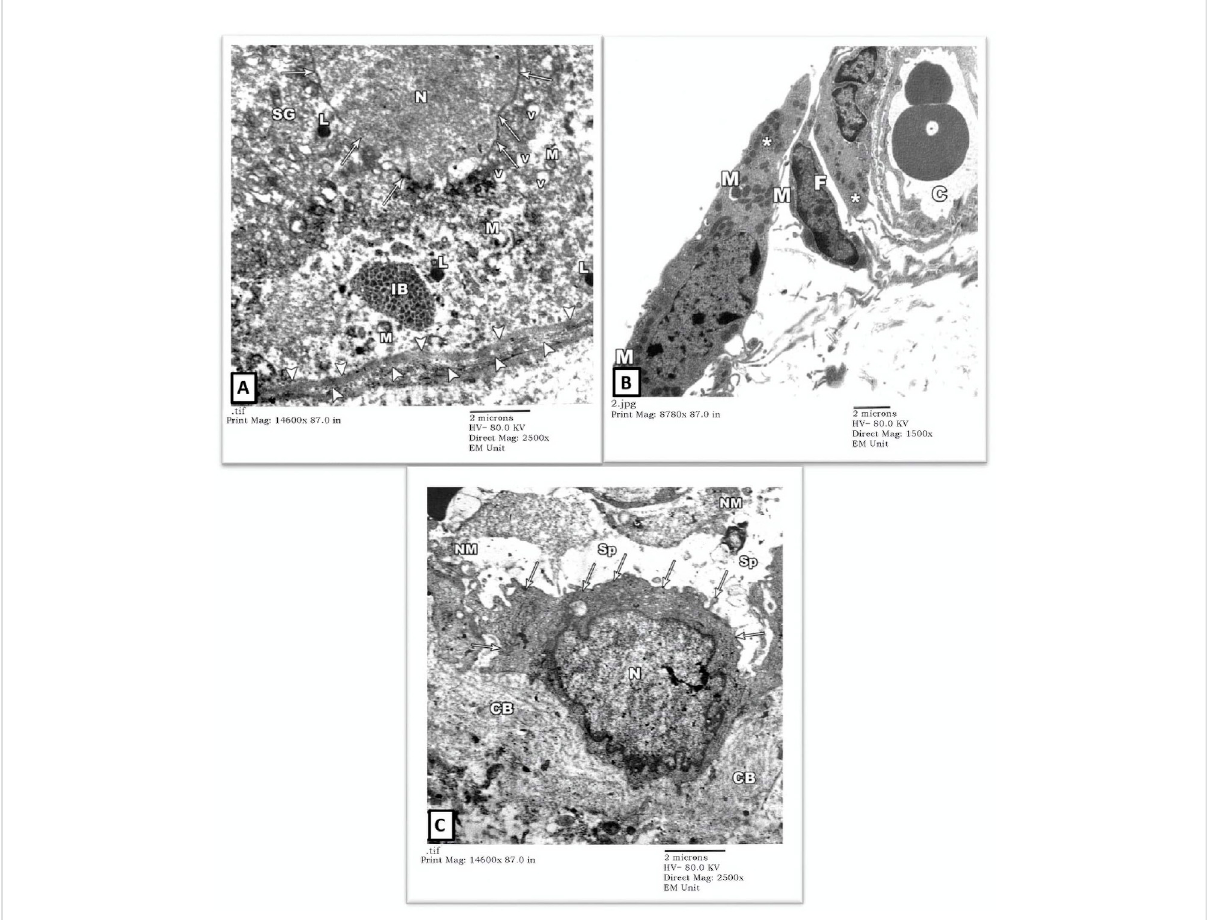
FIGURE 4 An electron micrograph of the testis from a rat in the cadmium group showing: (A) a part of the seminiferous tubule with thick wavy basement membrane (arrowheads). The nuclear membrane of the degenerated spermatogonium (SG) is irregular and disrupted (arrows). The cytoplasm is derangedwith vacuoles(V),disruptedmitochondria(M), lysosomes (L),and inclusionbodies(IB).(Uranyl acetate andleadcitrateX2500,Print Mag.X 14,600). (B) interstitium with widely spaced interstitial cells and dilated blood capillary (C). The cytoplasm of the Leydig cell (Asterisk) contained some mitochondria (M) but no apparent lipid droplets or sER. Notice the fi broblast (F). (Uranyl acetate and lead citrate X 1500, Print Mag. X 8780). (C) interstitium exhibiting a macrophage (arrows) with an irregularly outlined nucleus (N) and collagen bundles (CB) in its vicinity, necrotic material (NM) and wide spaces (Sp). (Uranyl acetate and lead citrate X 2500, Print Mag. X 14,600).